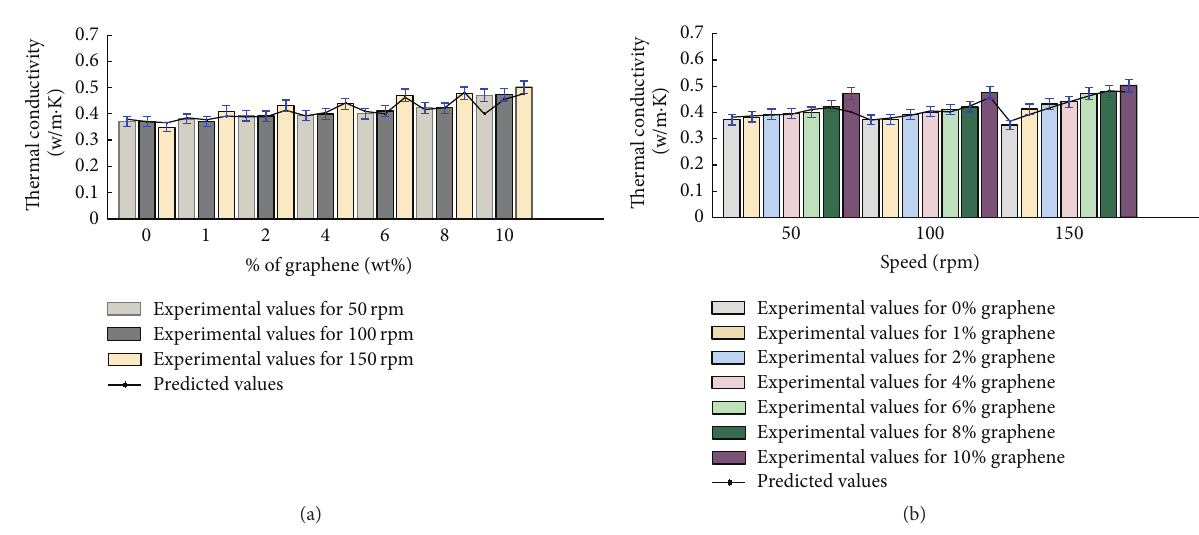
Figure 5: (a) Experimental versus predicted values of thermal conductivity of GNPs/LLDPE composites as a function of GNP wt%. (b) Experimental versus predicted values of thermal conductivity of GNPs/LLDPE composites as a function of extruder screw and feeder speed.